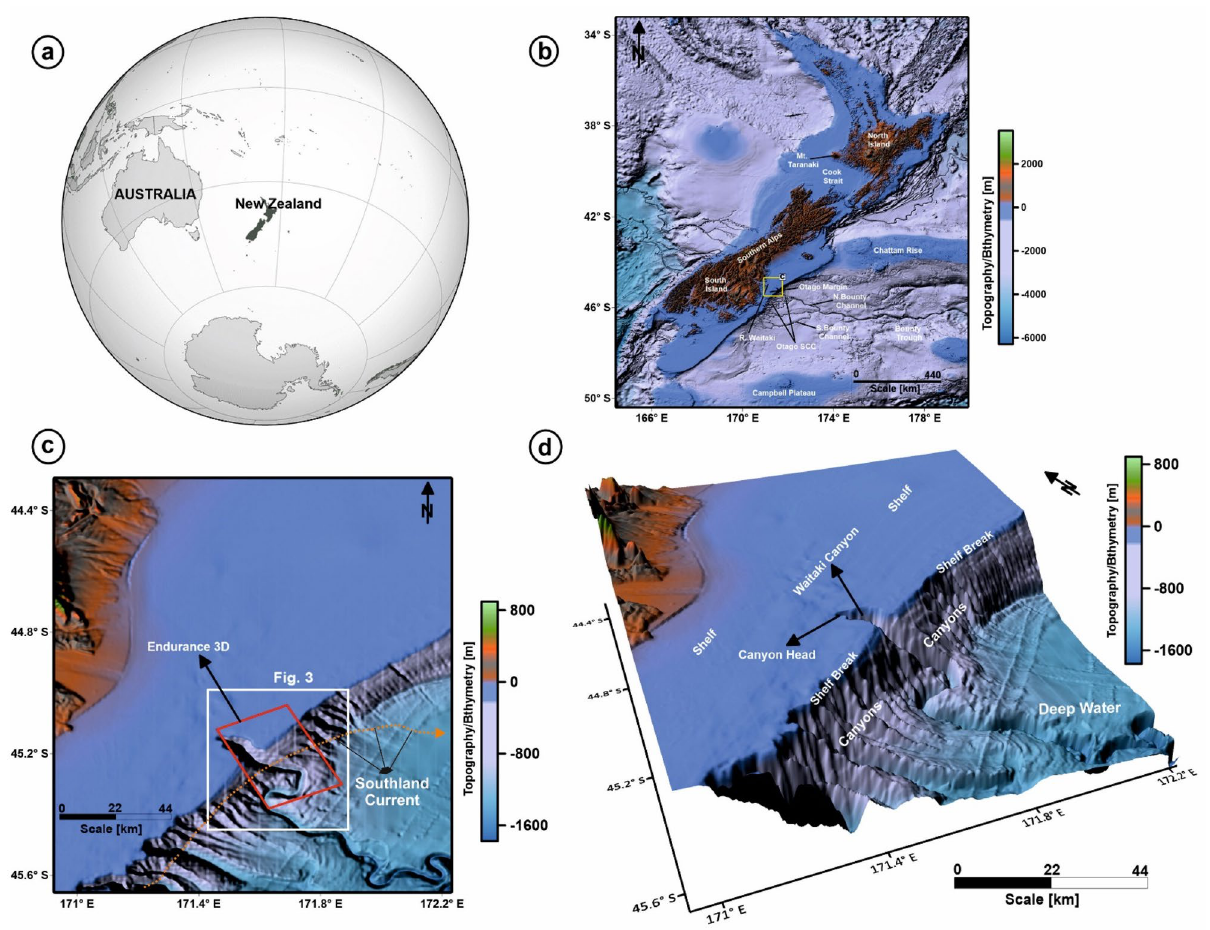
Complex (OSCC), which incises the Otago shelf. The Waitaki Submarine Canyon lies to the northern part of the continental shelf and is incised at the shelf-break, with its head trending towards the shelf. The location of the Endurance 3D seismic volume is highlighted by a red rectangular box in ( c ) around the Waitaki Submarine Canyon. The flow of the Southland Current is indicated by the orange dashed curve. The present-day Waitaki Submarine Canyon receives terrigenous sediments from the continental shelf that is distributed via rivers and canyons throughout the Bounty Trough. (The above maps are prepared using licensed version of Corel Draw v16 and OpendTect interpretation Suite